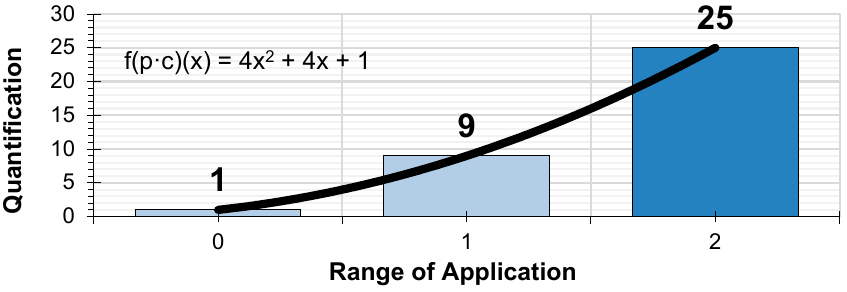
Figure 3. Quantification of probability and consequences.